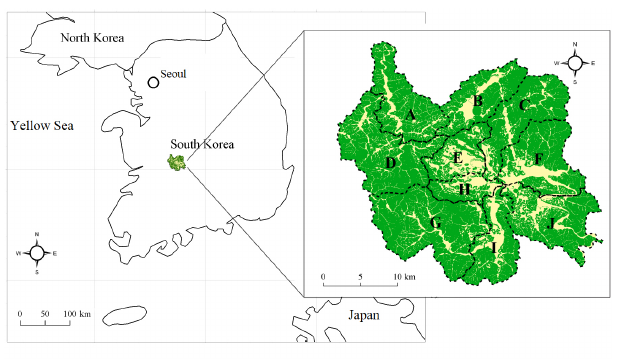
Fig. 1 . Map of Geumsan, South Korea. Light yellow area in the magnified map indicates the terrains of flat and lower slopes and roughly approximates the flat valleys. Green area indicates the mountainous terrains. The letters A to J in the magnified map indicate 10 administrative districts of